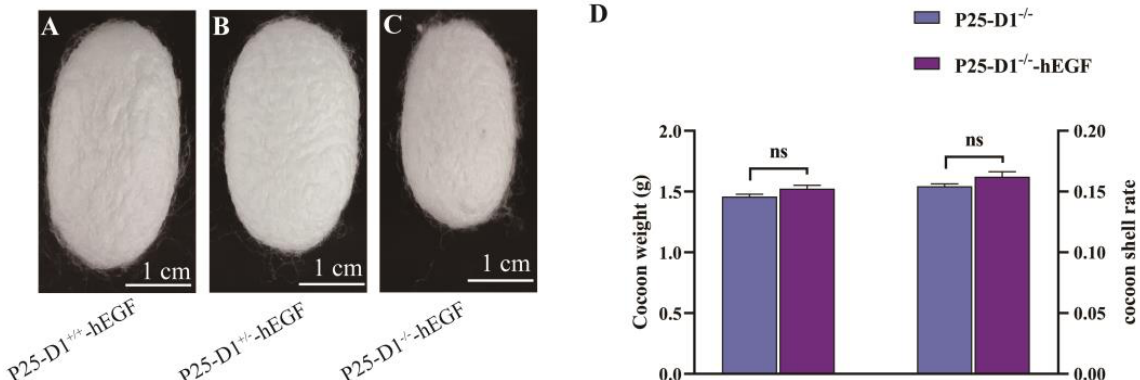
Figure 5. Phenotype and protein analysis of transgenic cocoons in a P25 gene knockout background. ( A – C ) Cocoon phenotypes of transgenic P25-D1 +/+ -hEGF ( A ), P25-D1 +/− -hEGF ( B ), and P25-D1 −/− -hEGF ( C ). ( D ) Cocoon weights and cocoon shell rates of non-transgenic P25-D1 −/− and transgenic P25-D1 − / − -hEGF. ns: no significant difference ( n = 18). The scale bars represent 1 cm.